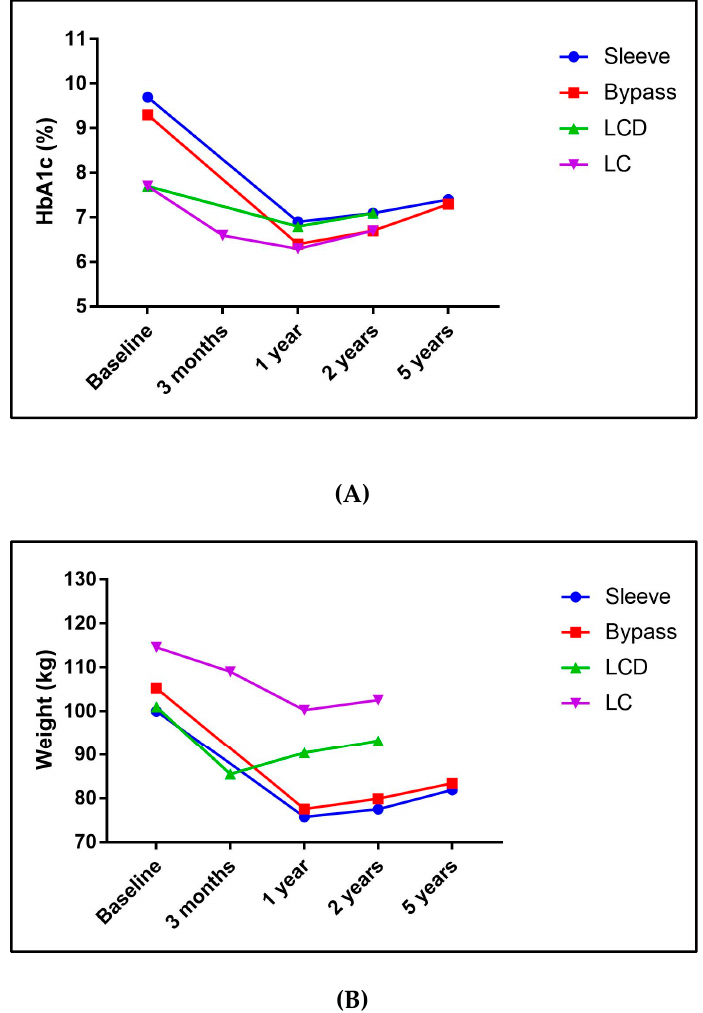
Figure 1. ( A ) Mean changes of hemoglobin A1c (HbA1c) from baseline to last published date for each study retrieved to represent the three methods of reversal; ( B ) mean changes of weight from baseline to last published date for each studies retrieved to represent the three methods of reversal. Note: We chose these three studies to represent the three methods of reversal based on publication date and relevance to diabetes reversal. Note that baseline characteristics differ. Surgery trial examined by sleeve gastrectomy and Roux-en-Y gastric bypass separately and were represented as sleeve and bypass in the graph. Surgery: STAMPEDE [34,35]. Low-calorie diets (LCD): DIRECT [65,66]; carbohydrate restriction (LC): IUH